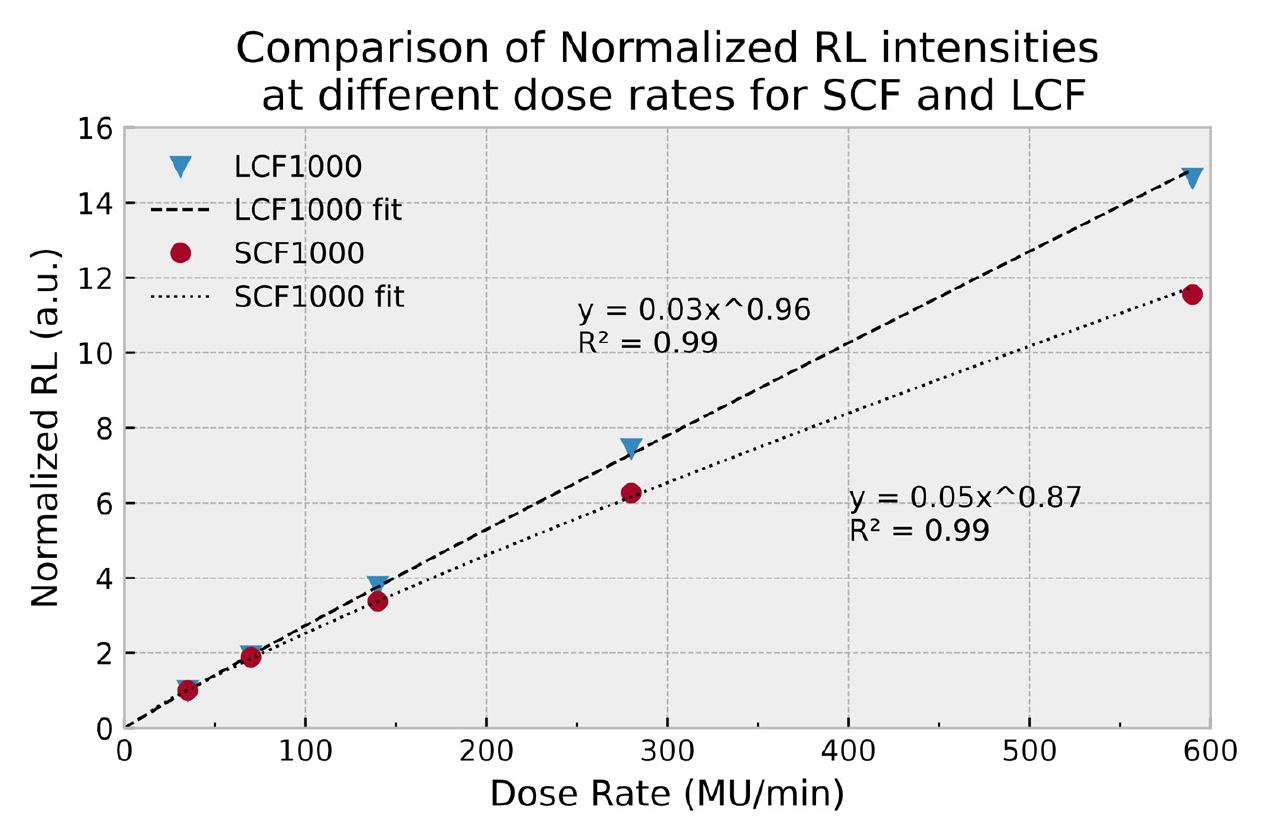
Figure 7. Normalized RL response/gate for SCF and LCF samples at various dose rates. Values are normalized to the response at lowest dose rate of 35 MU/min.